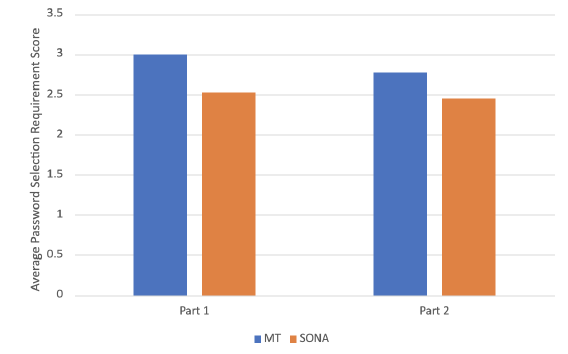
Figure 16. Password selection requirement Scores for for MTurk and SONA.